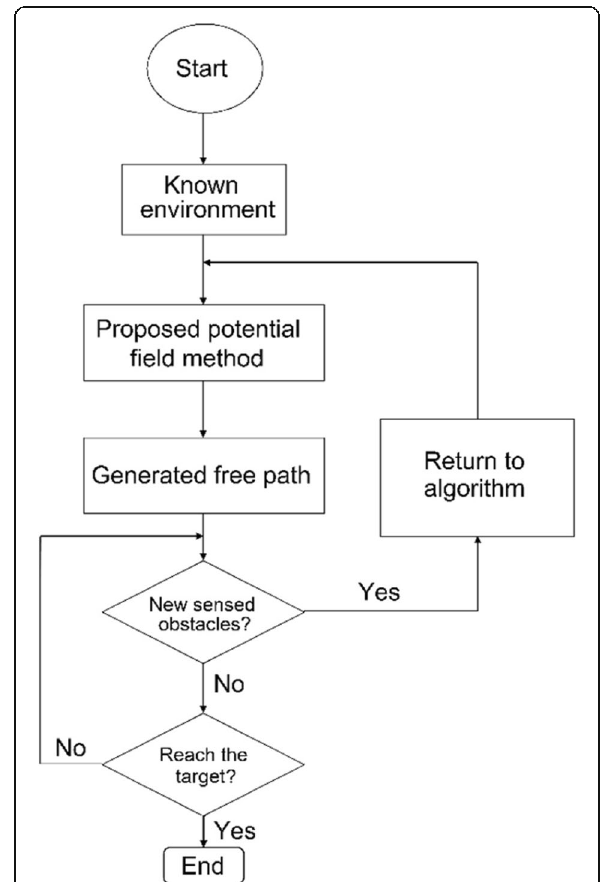
Fig. 6 The framework of the modified APF